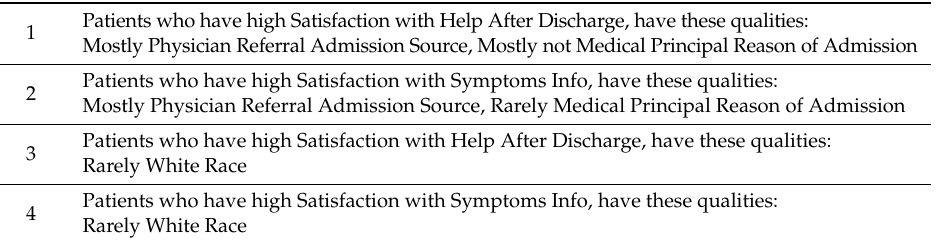
Table 10. Derived